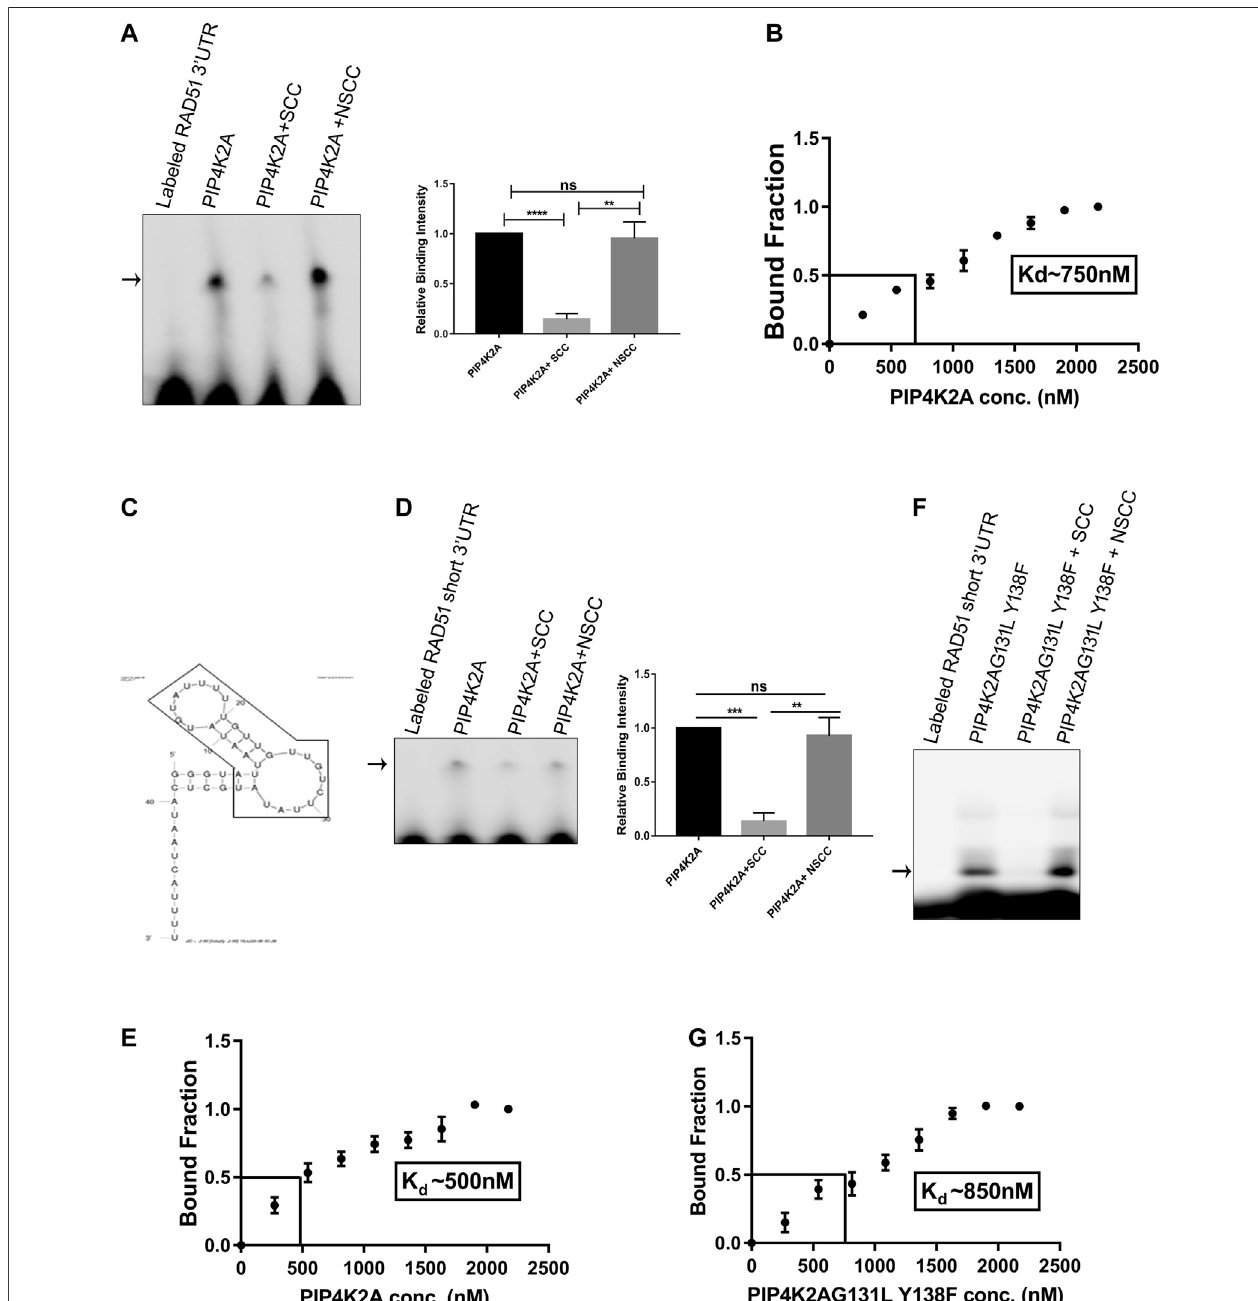
FIGURE 1 | PIP4K2A binds speci fi cally with RAD51 3 ′ UTR, and RNA binding activity is independent of kinase activity. (A) . PIP4K2A and labeled 3 ′ UTR of RAD51 wereincubatedat16 ° Cin1xGSBfor1 hinthepresenceorabsenceof10-foldexcessofunlabeledself-ornon-speci fi ccompetitor.Thereactionwasthenresolvedona 4%polyacrylamidegel for8 h at4 ° C,and thegels werescannedinaLI-CORscanner. Theshifted bandswerequanti fi ed using Image Jsoftware, andthe mean( ± SEM) relative band intensity was plotted (right panel), n (cid:1) 3; unpaired t -test, one tailed, **** (cid:1) p < 0.0001, ** (cid:1) p < 0.01, and ns (cid:1) p > 0.1. (B). RNA EMSA was performed withRAD51-3ÚTRandvaryingamountsofPIP4K2A,thebandintensitywasquanti fi edusingImageJsoftware,andthemean( ± SEM)ratioofboundtounboundfraction wasplottedforeachPIP4K2Aconcentration( n (cid:1) 3).ThevalueofK d wasobtainedbyextrapolating50%boundfractiononthe X -axis(PIP4K2Aconc.) (C) .Thepredicted secondary structure of RAD51 3 ′ UTR RNA indicating the formation of a stem loop structure by MFold algorithm. The RAD51-short sequence is boxed inside the arrow shape. (D). PIP4K2Aand labeled RAD51-short wereincubated at 16 ° Cin1xGSBfor 1 hin thepresence or absenceof10-fold excess ofunlabeled self- ornon-speci fi c competitor. The reactions were then resolved on a 1% agarose gel at 4 ° C, and the gels were scanned in a LI-COR scanner. The shifted bands were quanti fi ed using ImageJsoftware,andthemean( ± SEM)relativebandintensitywasplotted(rightpanel)( n (cid:1) 3);unpaired t -test,onetailed,*** (cid:1) p < 0.001,** (cid:1) p < 0.01,andns (cid:1) p > 0.1). (E). RNA EMSA was performed with RAD51-short RNA and varying amounts of PIP4K2A, the band intensity was quanti fi ed, and the mean ( ± SEM) ratio of bound to